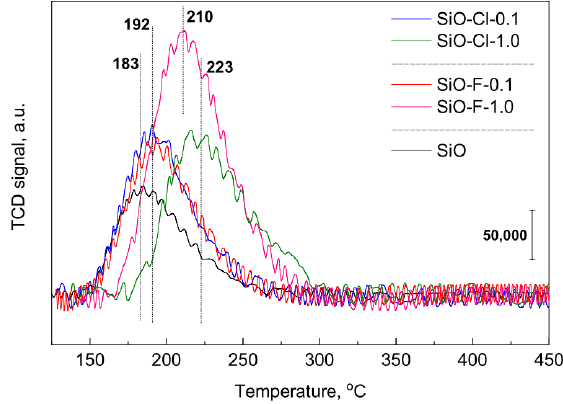
Figure 2. NH 3 -TPD profiles of silica samples calcined at 550 °C.